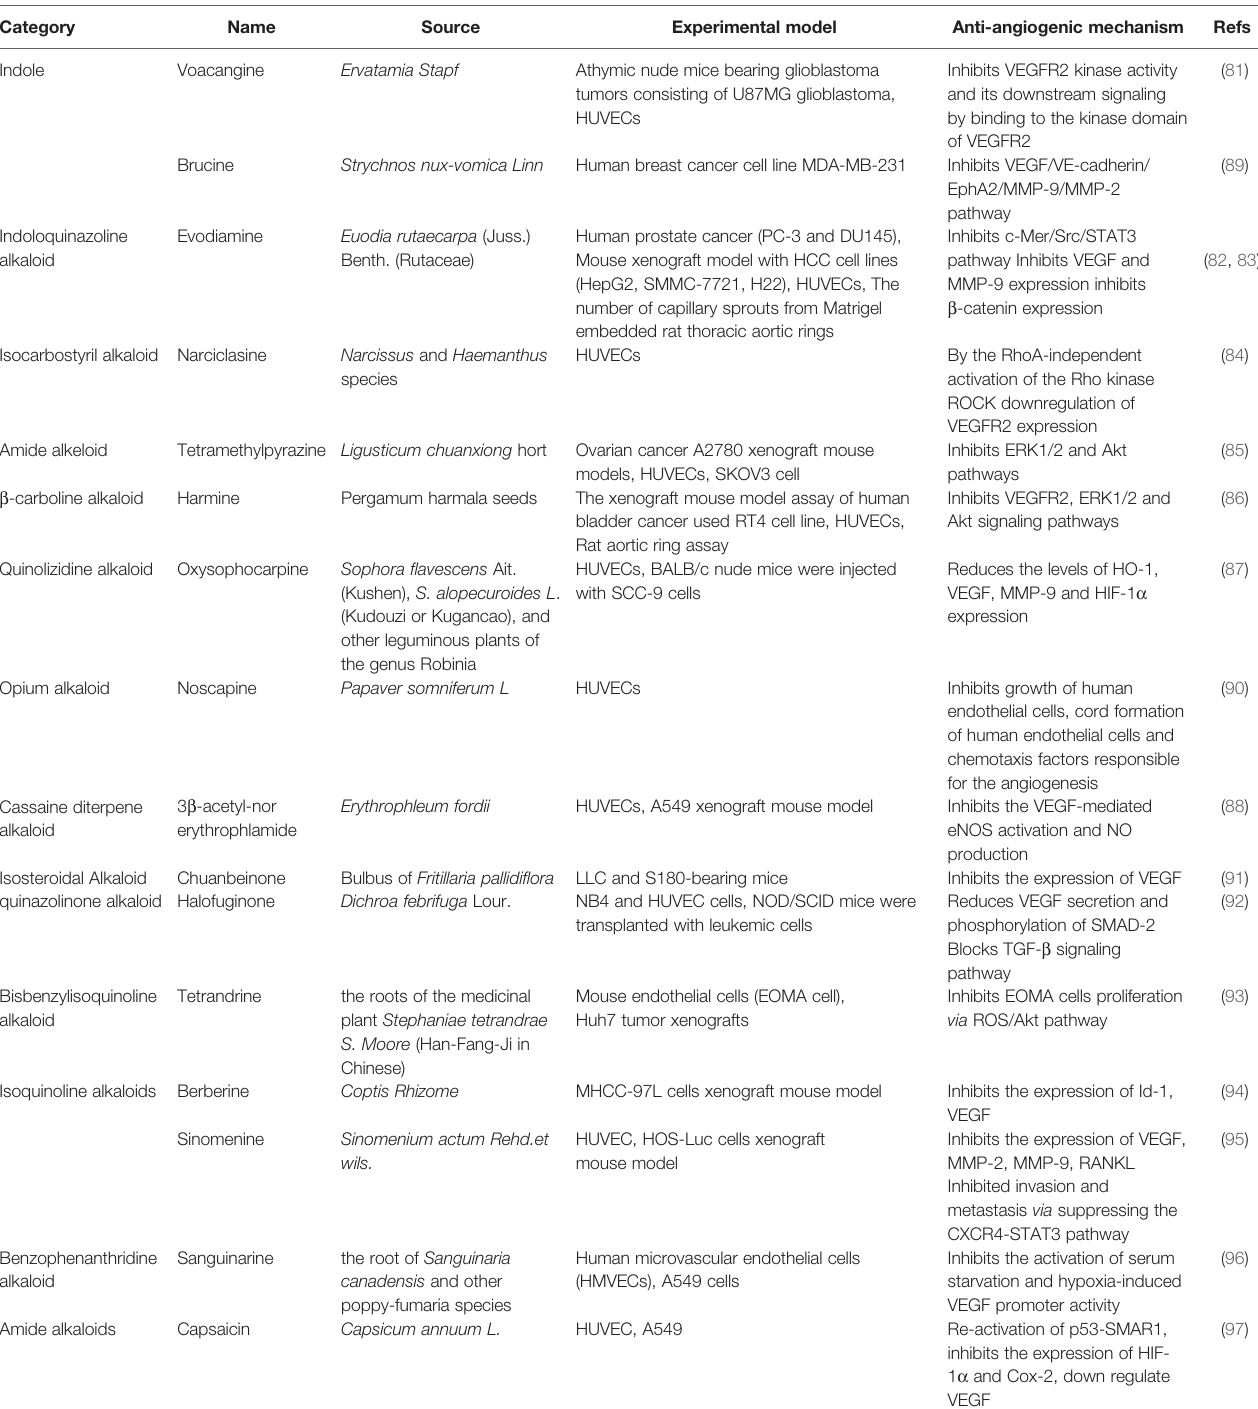
TABLE 4 | Natural anti-tumor angiogenesis alkaloids and their sources, experimental models and anti-angiogenic mechanisms.